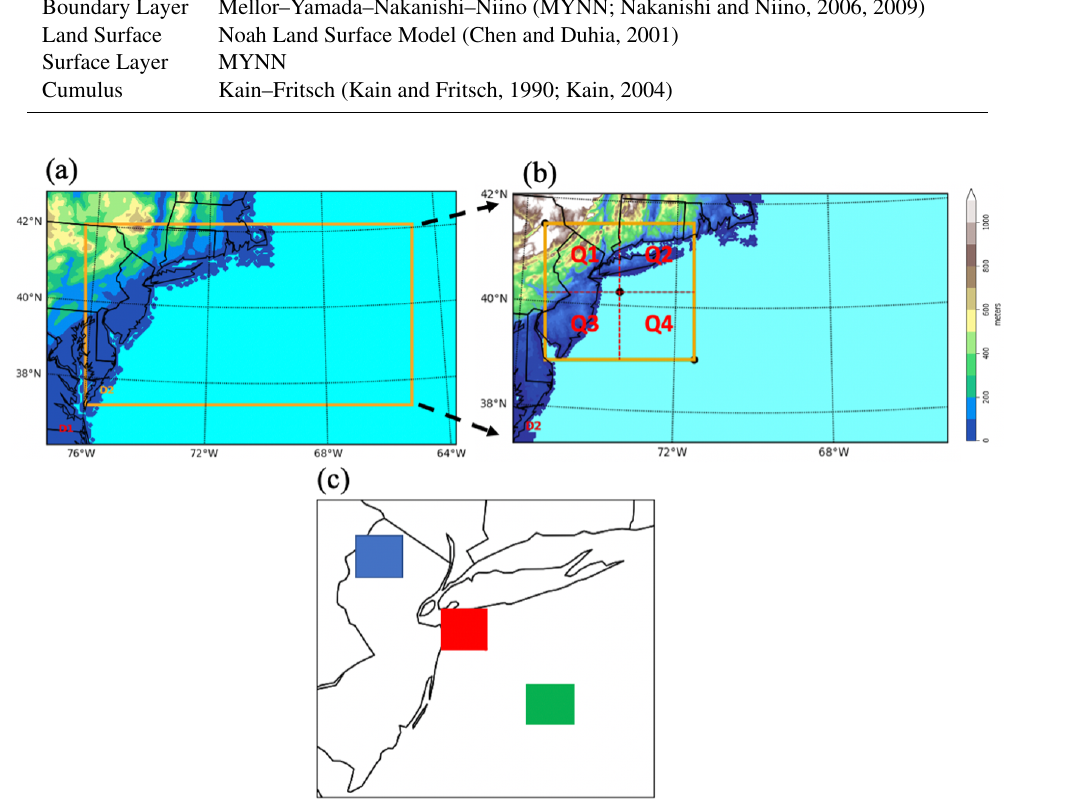
Figure 1. Spatial map for domain 1 (a) , domain 2 (b) and the New York metropolitan area (c) . The brown box in domain 2 marks the New York metropolitan area, and Q1, Q2, Q3 and Q4 represent quadrant 1, quadrant 2, quadrant 3 and quadrant 4 respectively. The blue, red and green boxes in (c) mark the regions over land, coast and ocean which are the subject of variability